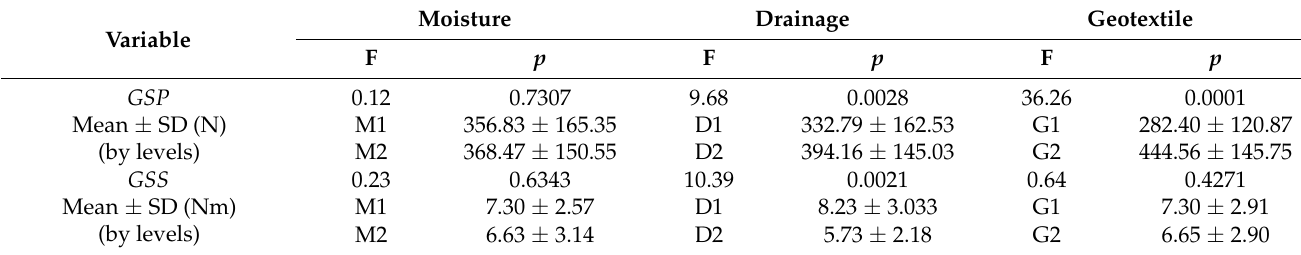
Table 2. Statistics for the GSP and GSS (f and p -value), mean and standard deviation of GSP and GSS from Going Stick to three factors moisture, drainage and geotextile addition.